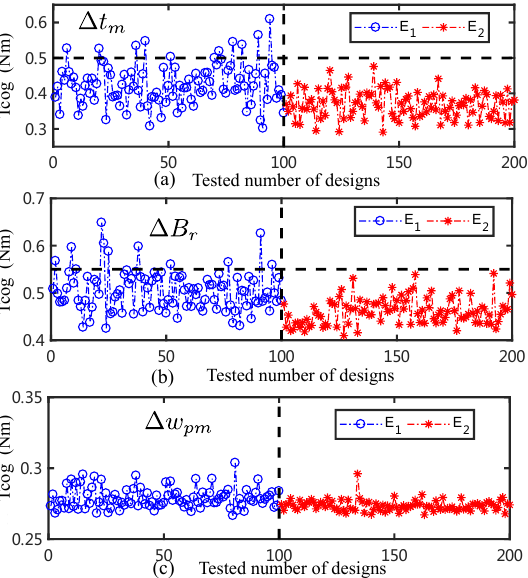
Figure 10. The comparison of peak-to-peak cogging torque performance for different PM assembling approaches considering a single type of uncertainties. ( a ) Uncertainties on the PM thickness ∆ t m ,